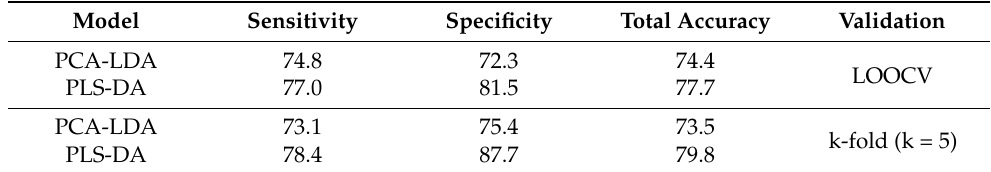
Table 2. Comparison of discrimination Performance of the DNA-damaged and DNA-intact sperm cells, validated with LOOCV and k-fold method.